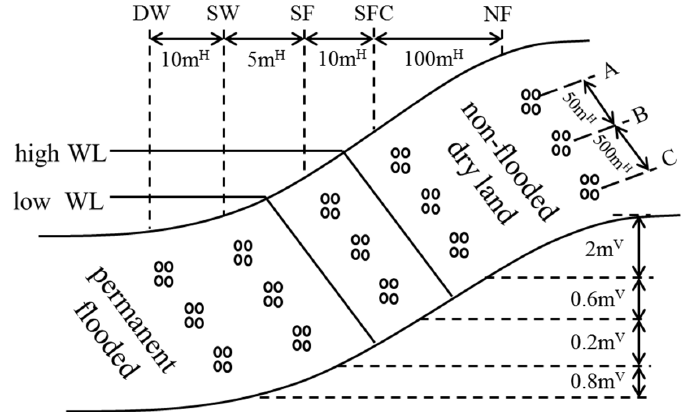
Figure 1. Experimental design [17,18]. WL: water level. The difference between high WL and low WL was caused by summer flooding. m H indicates meters in horizontal; m V indicates meters in vertical. The sites are grouped at different heights. DW: deep water site; SW: shallow water site; SF: seasonally flooded site; SFC: ’control site’ for the seasonally flooded site; NF: non-flooded site. A, B and C denote samples from different vegetation types within each height band. For more details on water depth and other environmental parameters, see Table 1, Figures 2 and S1. Table 1. Physicochemical properties (Mean ± SE (standard error)) of soil/sediment of each site. DW: deep water site; SW: shallow water site; SF: seasonally flooded site; SFC: ’control site’ for the seasonally flooded site; NF: non-flooded site. A, B and C denote samples from different vegetation types within each height band, species details see Table S1.